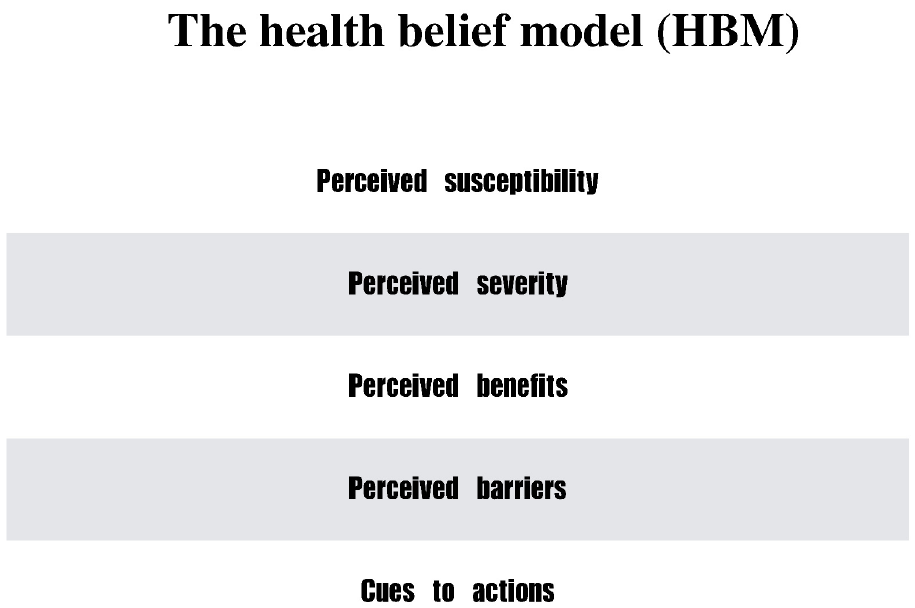
Figure 1. Constructs of health belief model (HBM).